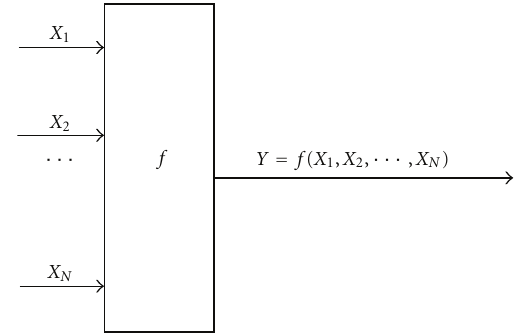
Figure 1: Model with input and output variables, extracted from